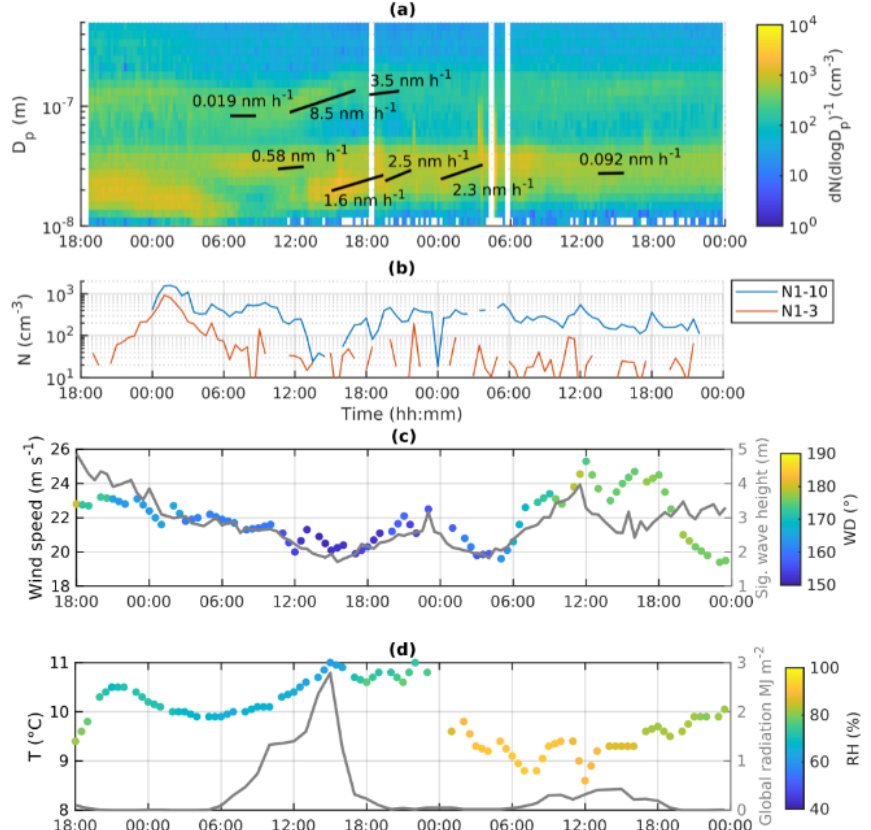
Figure 11. An example of particle size distribution and observed growth rates (a) with the 1–3 and 1–10nm particle number concentrations observed with PSM (b) from 8 November at 18:00 to the end of 10 November 2020 and meteorological conditions (c, d) . The vertical white stripes in the size distribution correspond to land-influenced periods that were not included